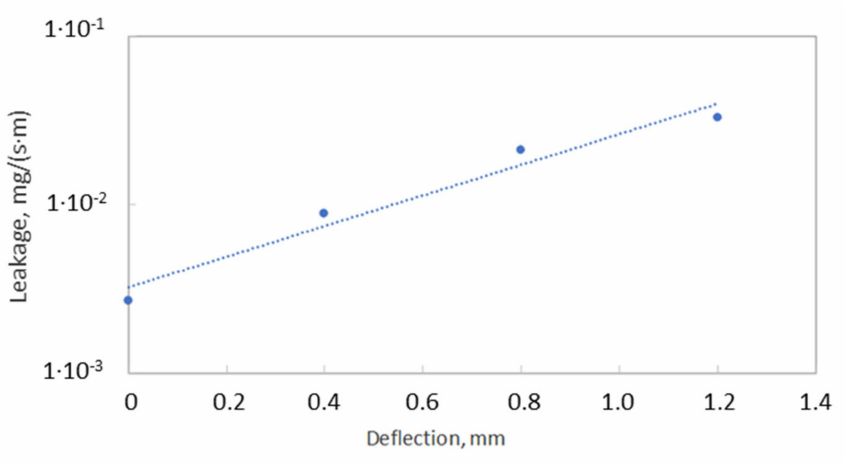
Figure 16. Leakage level vs. pipe